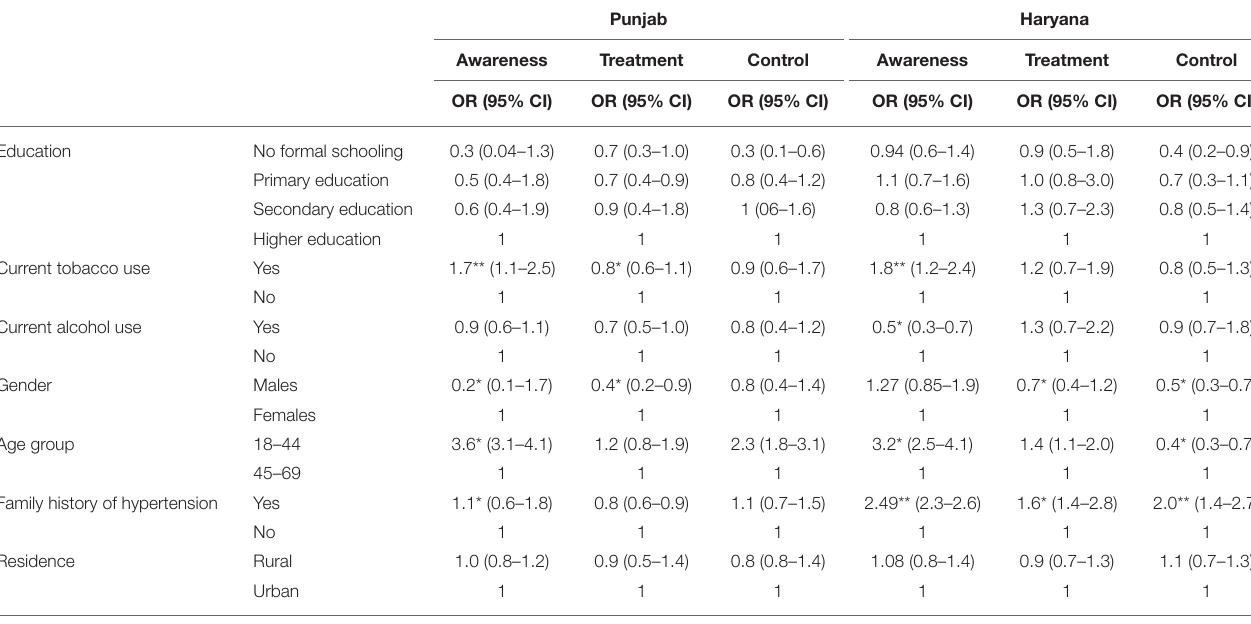
TABLE 4 | Multivariable Logistic Regression Model to assess Factors associated with awareness, treatment, and control of hypertension in Punjab and Haryana, India. Punjab Haryana Awareness Treatment